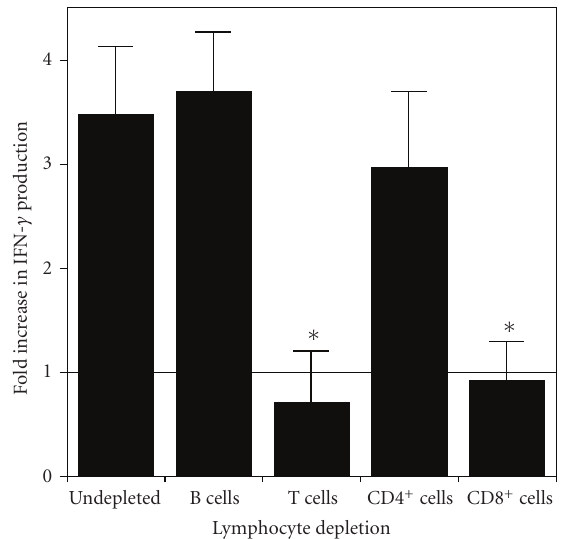
Figure 1: IFN- γ production by splenocytes from mice immunized with tomatine- P. berghei CS peptide following ex vivo restimula- tion with P. berghei CS peptide (25 μ g/mL). Lymphocyte subset depletion was performed by immunomagnetic cell sorting to > 98% purity. Data are fold increases in cytokine secretion over that of splenocytes from identically immunized mice not restimulated ex vivo (by convention, value = 1.0, depicted as a horizontal line). Data shown represent the mean of four mice, assayed individually in triplicate, from one of four similar experiments. ∗ P < . 05 versus other groups, determined by the one-way ANOVA